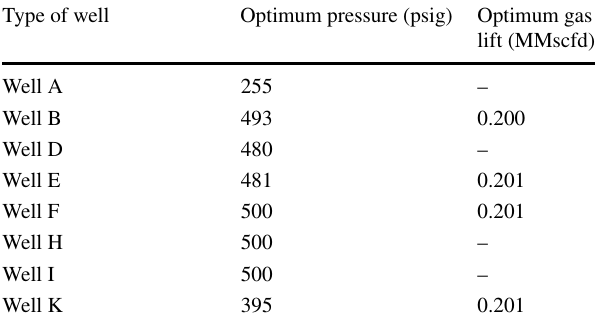
Table 3 Optimum process variables to maximize the oil